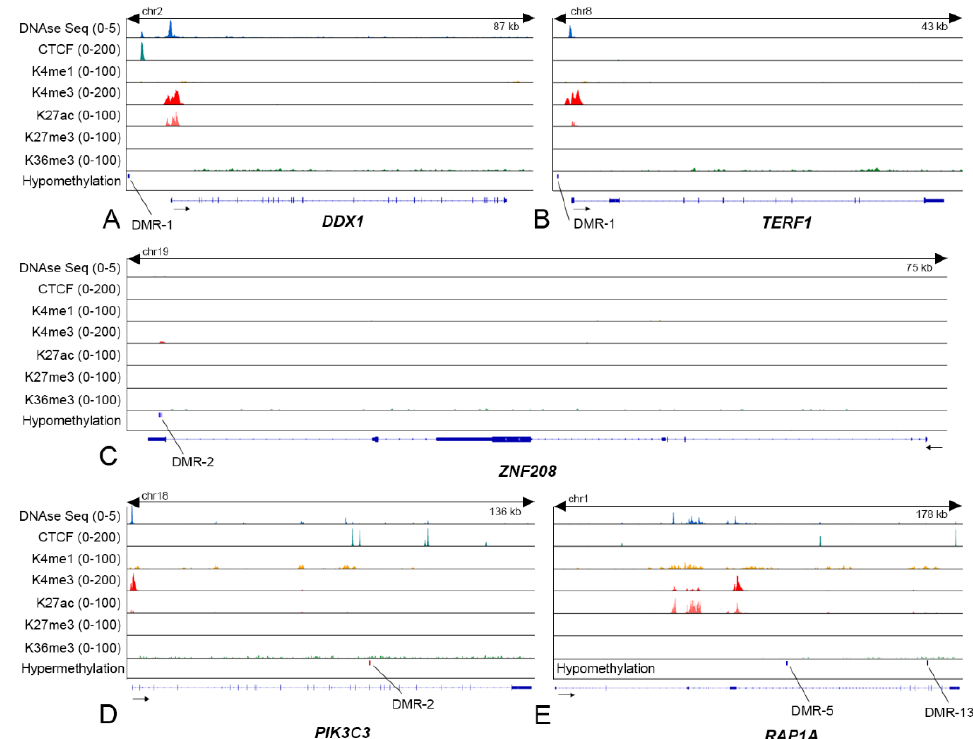
Figure 5. Proximity and possible overlaps between DMRs and chromatin marks were mapped on selective epigenetically regulated TRGs ( n = 5). ChIP-sequencing data from H929, t(4;14) cell line containing four activating histones (H3K4me1, H3K4me3, H3k27ac, and H3K36me3), and one repressive histone (H3K27me3) were mapped to the proximal DMRs. Additionally, DNAse-seq peaks were observed to determine open chromatin, while CTCF binding was also observed. The overlaps between DNA and chromatin level epigenetic marks were visualized at 5 kb upstream TSS of ( A ) DDX1 and ( B ) TERF1 , or across the body region of ( C ) ZNF208 , ( D ) PIK3C3 , and ( E ) RAP1A . Abbreviations: ChIP, chromatin immunopre- cipitation; CTCF, CCCTC binding factor; DMR, differentially methylated regions; DNAse-seq, DNAse sequencing; TRG, telomere-related gene; TSS, transcription start